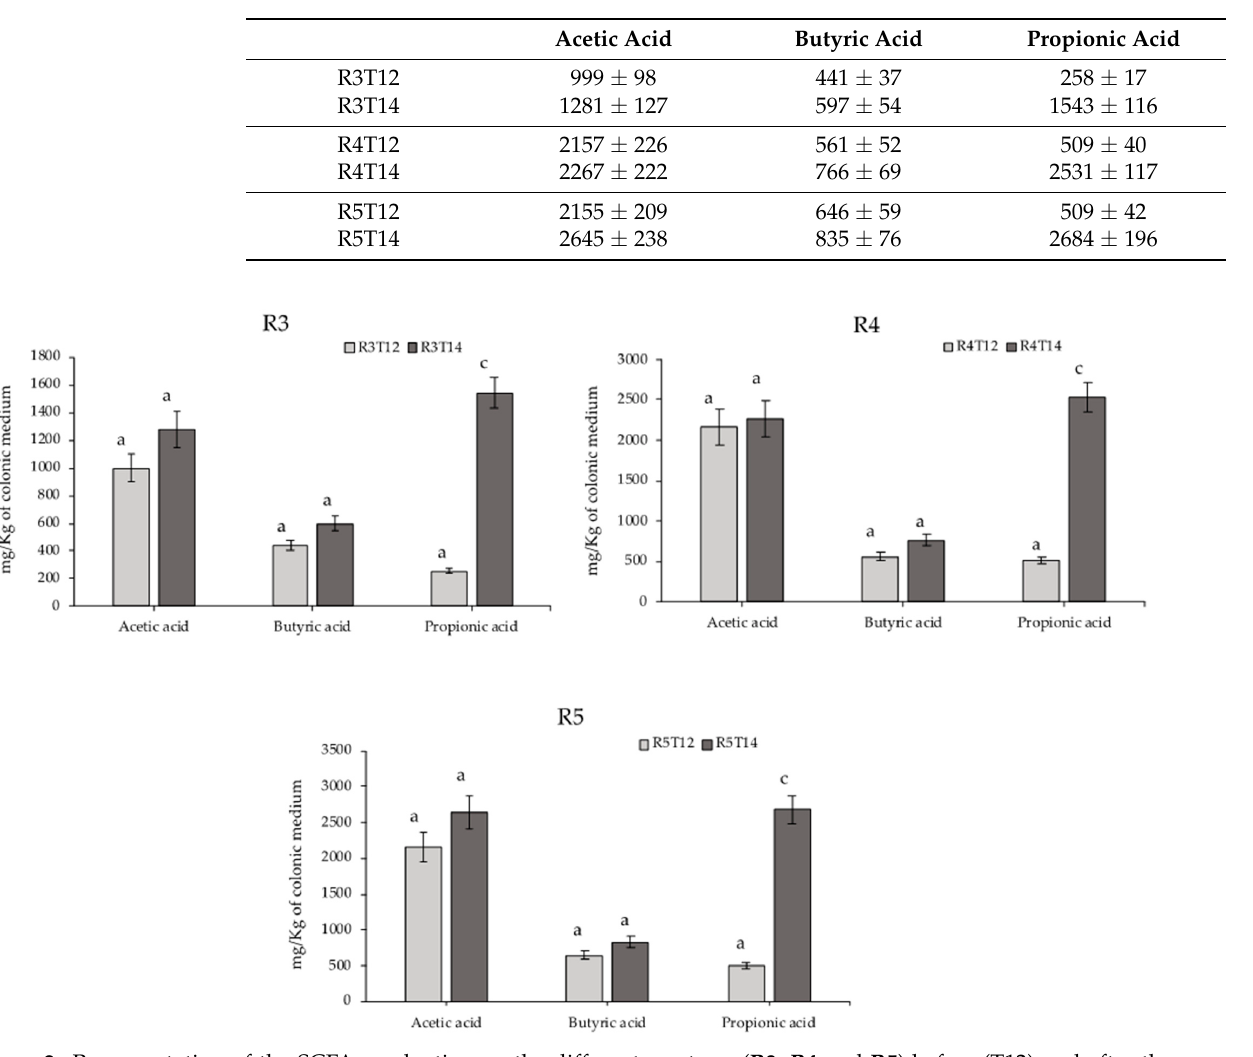
Table 2. SCFA production in the three reactors after the stabilization period (T12) and the treatment period (T14) (mg/Kg of colonic medium).